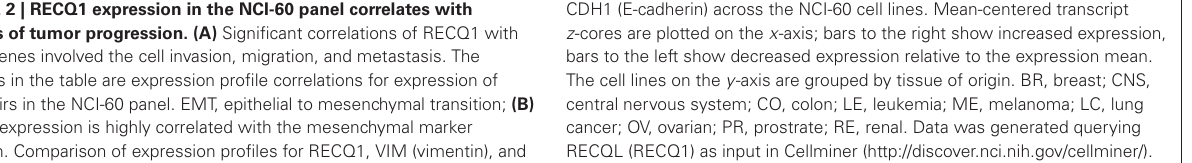
FIGURE 2 | RECQ1 expression in the NCI-60 panel correlates with markers of tumor progression. (A) Significant correlations of RECQ1 with select genes involved the cell invasion, migration, and metastasis. The numbers in the table are expression profile correlations for expression of gene pairs in the NCI-60 panel. EMT, epithelial to mesenchymal transition; (B) RECQ1 expression is highly correlated with the mesenchymal marker vimentin. Comparison of expression profiles for RECQ1, VIM (vimentin), and